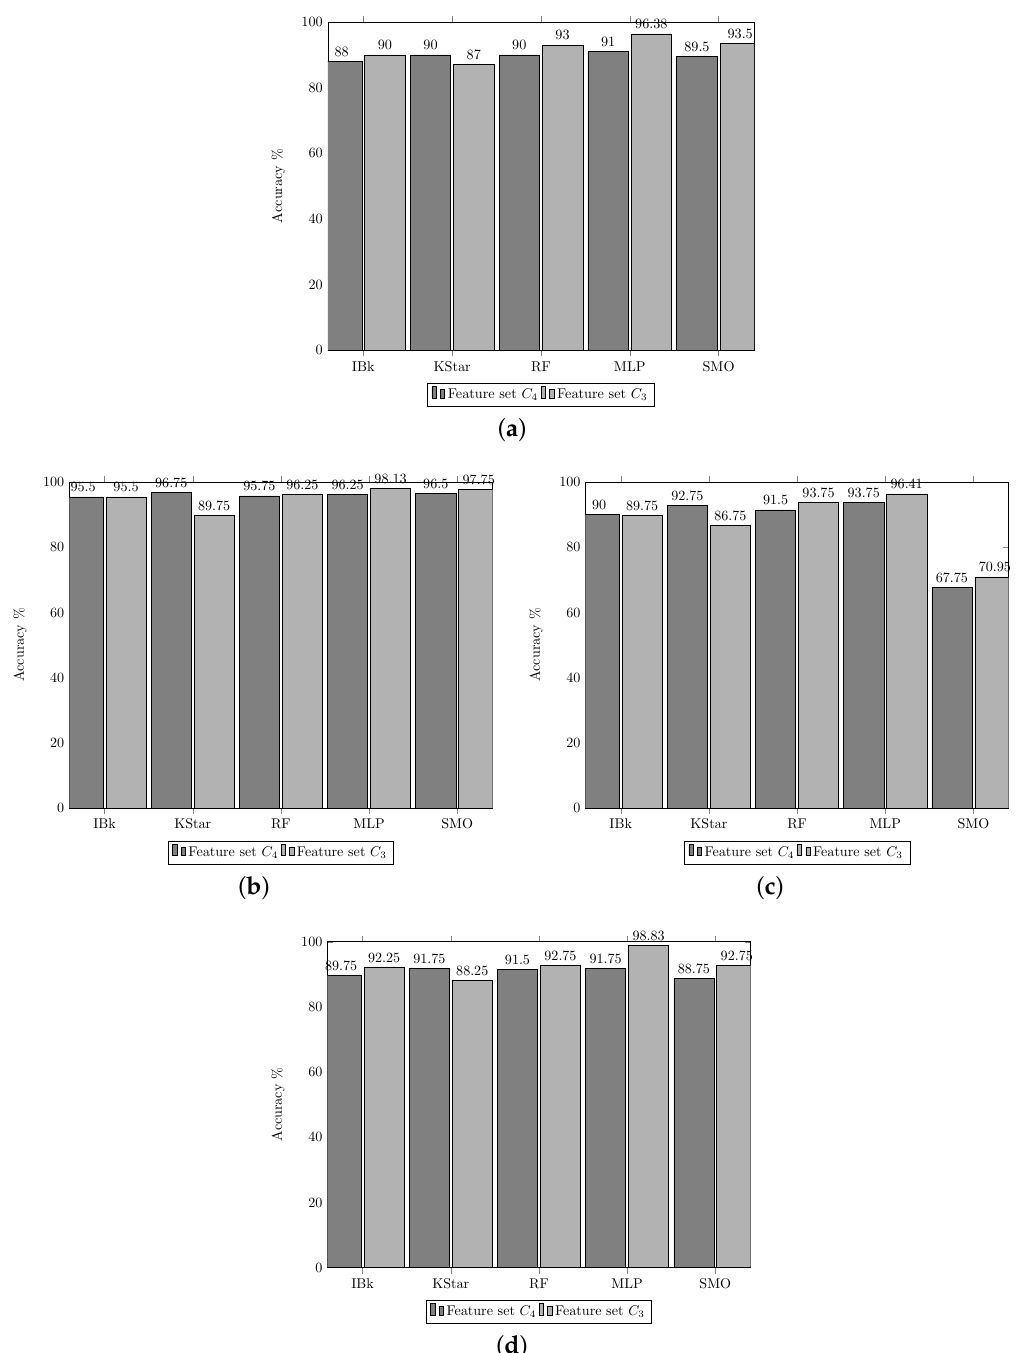
Figure 8. Experiments 2 and 3. Pre-classification using multiclass classifiers (experiment 2) and the q 2 architecture, and binary classifiers and the q 3 architecture (experiment 3). ( a ) Pre-classification using multi-class classifiers (G1, G2, and G3). ( b ) Binary group 1, conformed by chromosomes 1 to 5. ( c ) Binary group 2, conformed by chromosomes 7 to 15. ( d ) Binary group 3, conformed by chromosomes 16 to